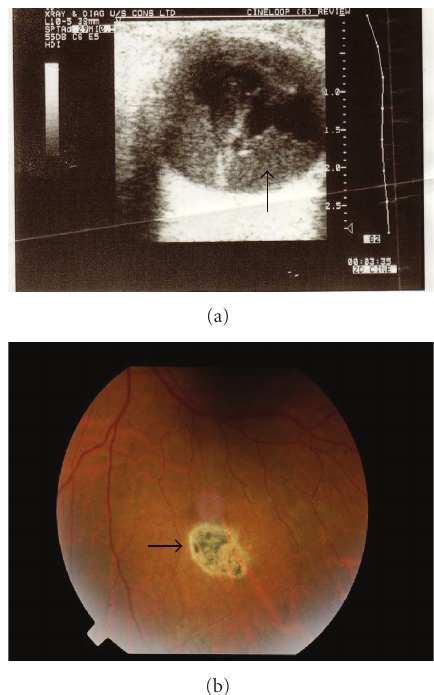
Figure 1: (a) Ultrasound image of the left eye of the patient demon- strating vitreous hemorrhage. (b) Black starburst in peripheral retina of left eye.